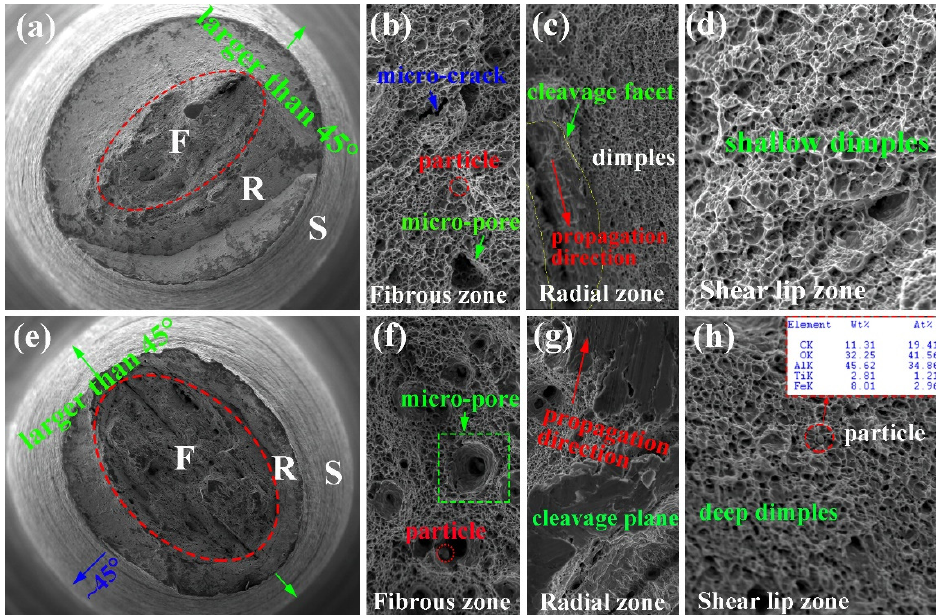
Figure 6. SEM micrographs of the tensile fracture of the specimen in the surface of steel A and B. ( a , e ) low magnification of the fracture, F stands for fibrous, R stands for radial, and S stands for shear lip; ( b , f ) high magnification of fibrous zone; ( c , g ) high magnification of radial zone; ( d , h ) high magnification of shear lip zone.